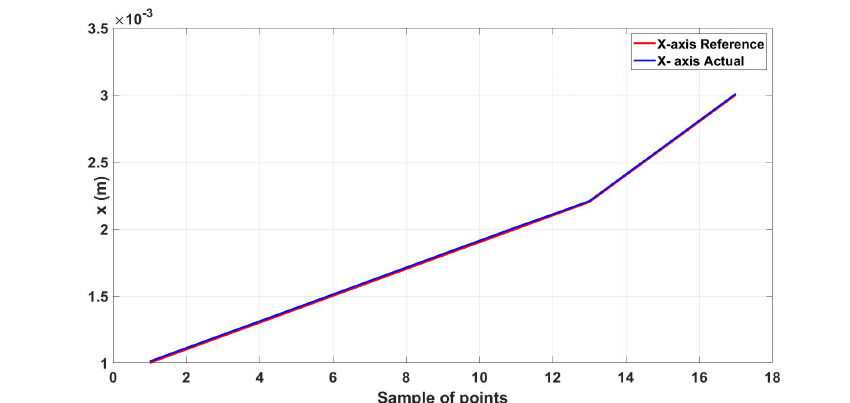
Figure 12. Actual and reference position of the diamond trajectory in the x-axis.